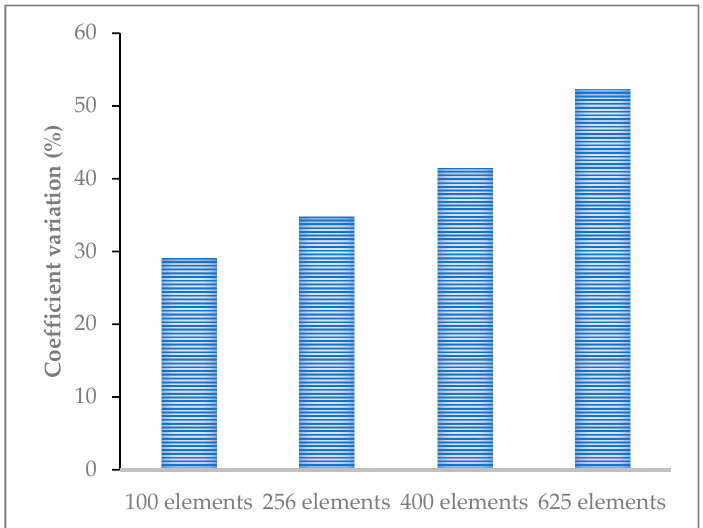
Figure 2. The results of coefficient variation calculated by different element size division.